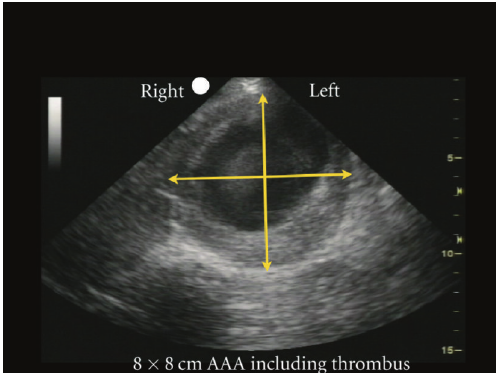
Figure 25: Abdominal aortic aneurysm (AAA) measured, short axis